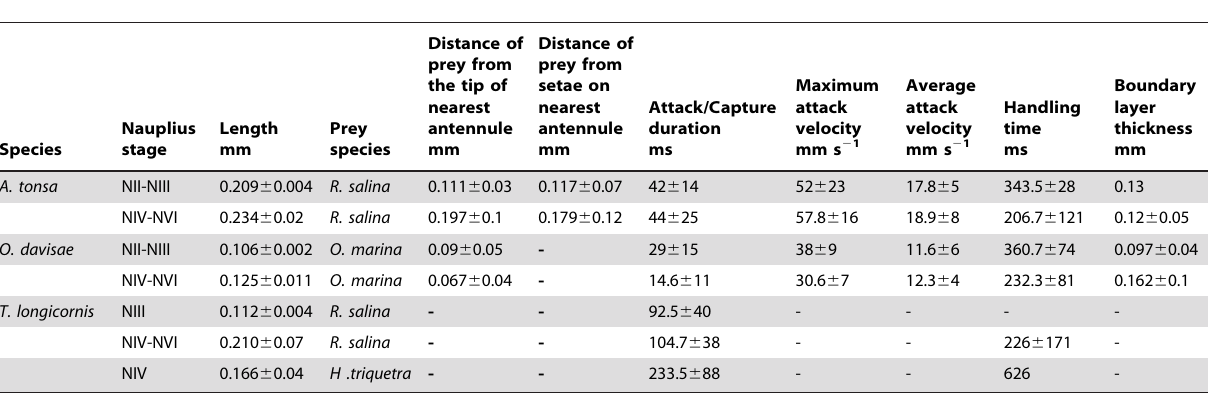
Table 1. Characteristics of the observed nauplii and of the attacks.